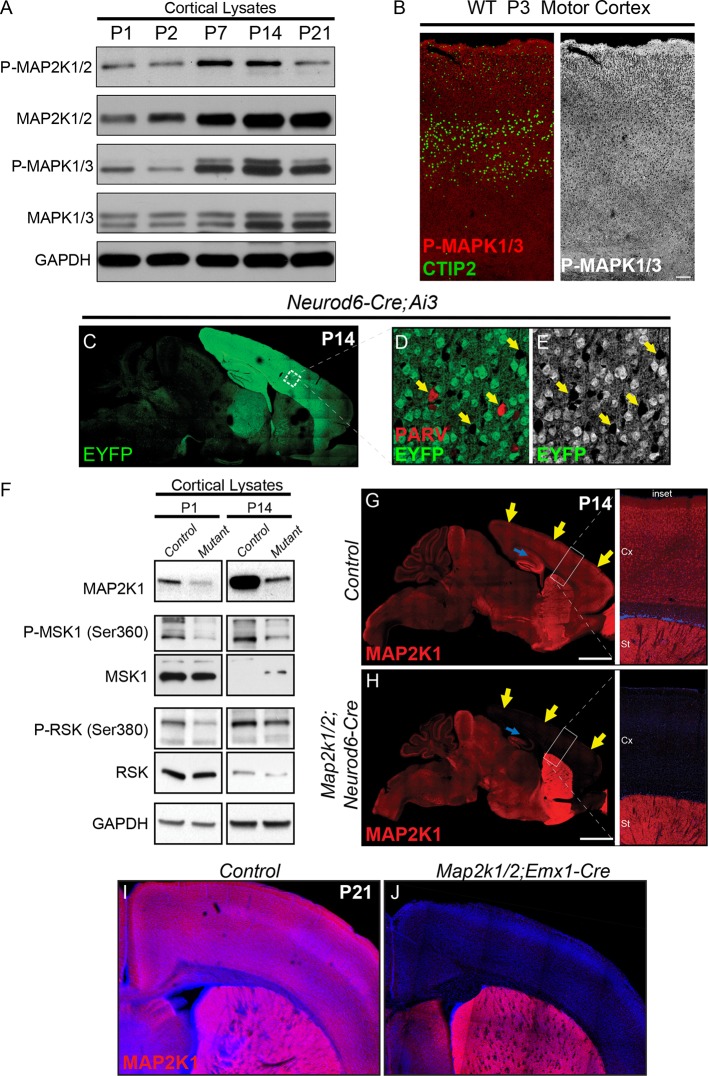
Developmental changes in ERK/MAPK activity and mouse models for loss of ERK/MAPK signaling in cortical excitatory neurons.(A) Whole cortical lysates show significant changes in the expression and phosphorylation of ERK/MAPK components, MAP2K1/2 and MAPK1/3(ERK1/2), during the first three weeks of postnatal development (n=3). (B) Immunofluorescent staining reveals the ubiquitous distribution of activated, phospho-MAPK1/3(ERK1/2) in all cortical layers in P2-3 mouse sensorimotor cortices. (n=3, scale bar=200 µm) (C–E) Neurod6-Cre induces recombination of the Cre dependent EYFP reporter, Ai3, in postmitotic excitatory neurons throughout the cortex as shown here in P14 (C) sagittal brain sections. Parvalbumin expressing GABAergic interneurons (D, arrows) do not exhibit EYFP expression (E), further demonstrating the specificity of recombination in excitatory neurons. (F) P1 and P14 Map2k1/2;Neurod6-Cre cortices show pronounced loss of MAP2K1 expression and reduced phosphorylation of ERK/MAPK pathway substrates, RSK and MSK (n=5). (G–H) Representative confocal images of P14 control mouse brains show that cortical excitatory neurons in the cortex and hippocampus exhibit a high level of MAP2K1 immunolabeling (G). MAP2K1 levels are profoundly reduced in the cortex (yellow arrows) and hippocampal subfields CA1-CA3 (blue arrow) in P14 Map2k1/2;Neurod6-Cre mice (H) (n=6, scale bar=2 mm). (I–J) MAP2K1 expression is absent in the cortex of Map2k1/2;Emx1-Cre mice (J) when compared to P21 littermate control cortices (I) (n=3).